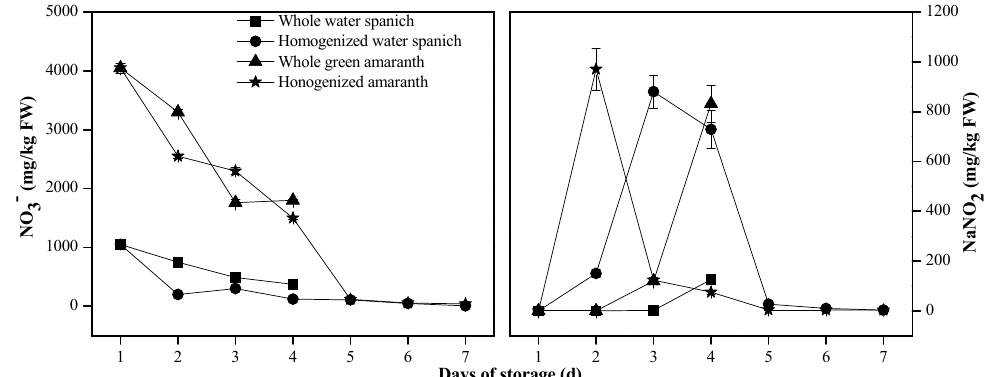
Figure 3. A laboratory test indicates the variation of nitrate and nitrite contents in water spinach ( Ipomoea aquatica Forssk. ) and green amaranth ( Amaranthus tricolor L.) in the whole and homogenized forms stored at ambient temperature (30 °C) for persistent seven days.